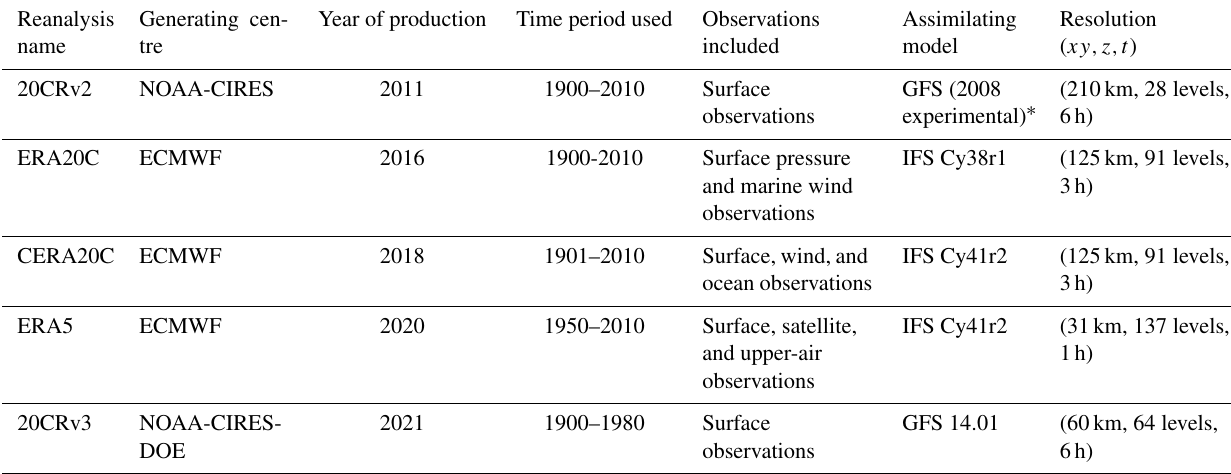
Table 1. A summary of the five reanalysis products analysed in this paper. For references to full descriptions of the products, see main